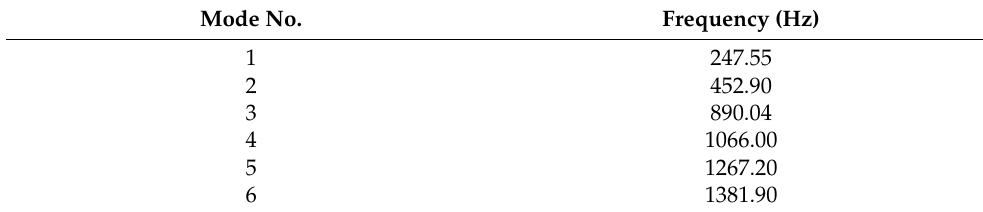
Table 4. The 1st to 6th natural frequencies of the swing micro-mirror structure. Mode